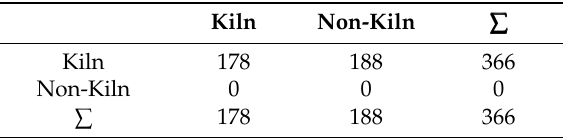
Table 1. Confusion matrix for the output of the analyses based on the Faster R-CNN. Columns show the labelling in the reference data while rows the labelling in the classifier output.